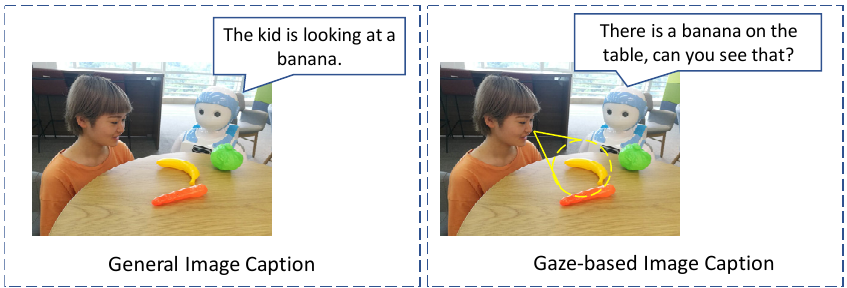
Figure 1. The difference between general image caption and gaze-based image caption.